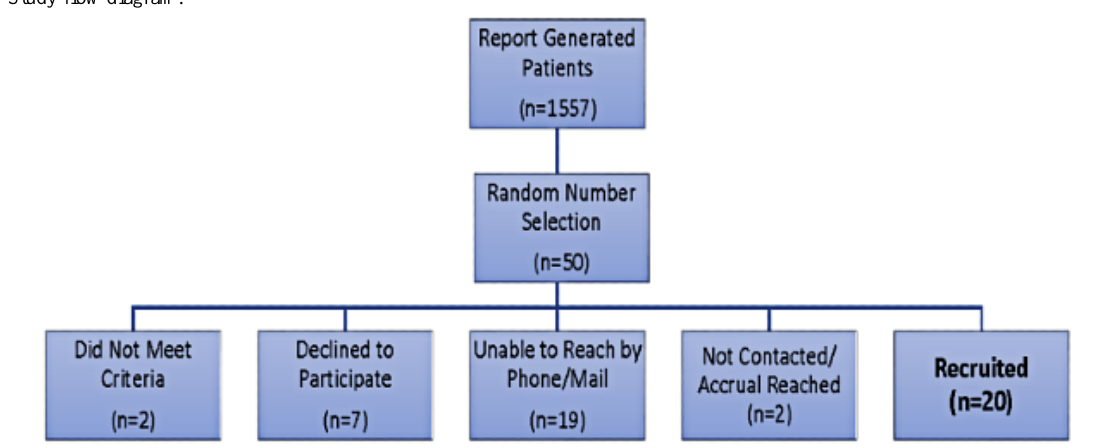
Figure 1. Study flow